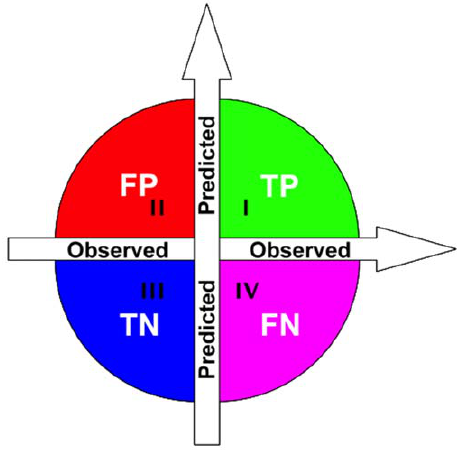
Figure 3. An illustration to show the predicted results fallen into four different quadrants. (I) TP, the true positive quadrant (green) for correct prediction of positive dataset, (II) FP, the false positive quadrant (red) for incorrect prediction of negative dataset; (III) TN, the true negative quadrant (blue) for correct prediction of negative dataset; and (IV) FN, the false negative quadrant (pink) for incorrect prediction of positive dataset.